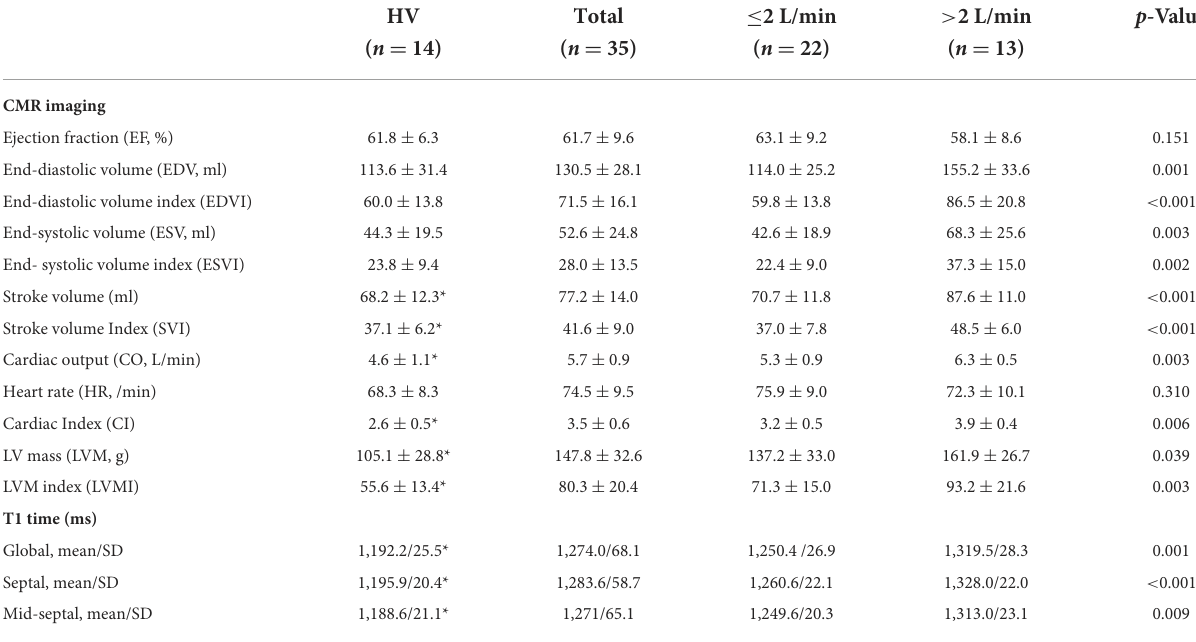
TABLE 2 Comparison of CMR parameters between patients with a Qa > 2 vs. ≤ 2